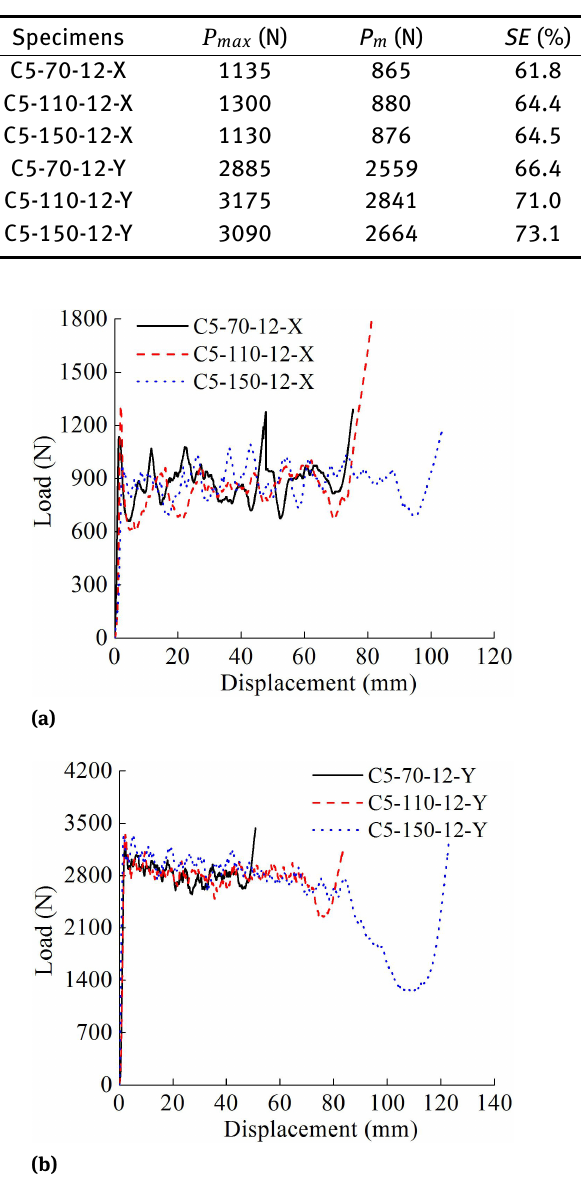
Figure 13: Load and displacement curves of regular pentagon paper corrugation tubes with different tube lengths: (a) tubes along X direction; (b) tubes along Y direction